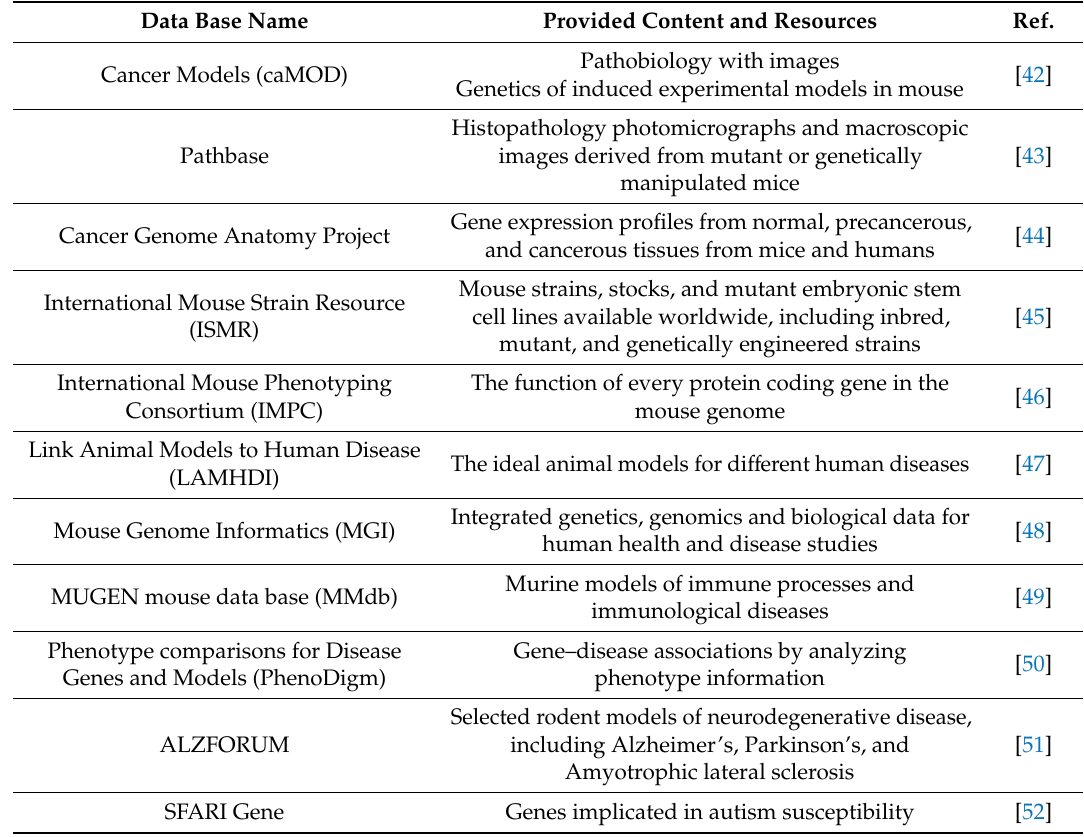
Table 1. Representative animal model